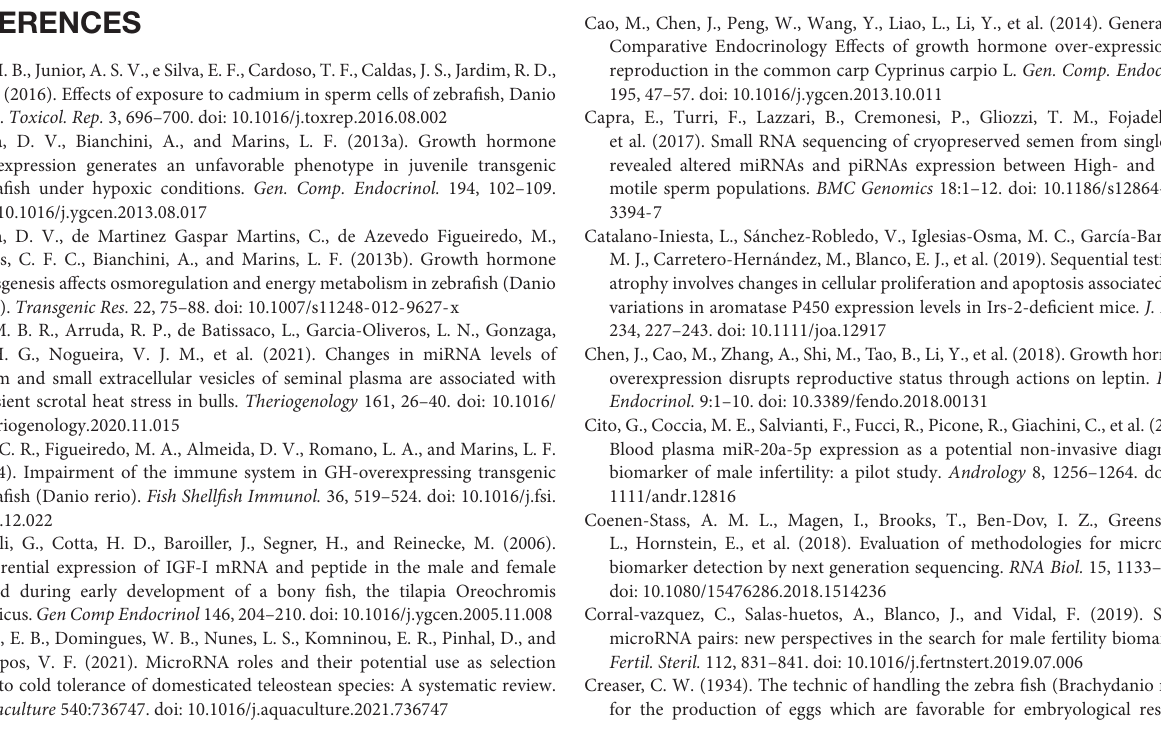
Supplementary Figure 1 | Qualitative analysis of RNA quality isolated from zebrafish sperm cells samples. Representative total RNA samples quality parameter analyzed by TapeStation 4200. RNA from sperm cells of gh -transgenic (A1, B1, and C1) zebrafish ( Danio rerio ) belonging to the F0104 strain and non-transgenic groups (D1, E1, and F1) are compared with electronic Ladder